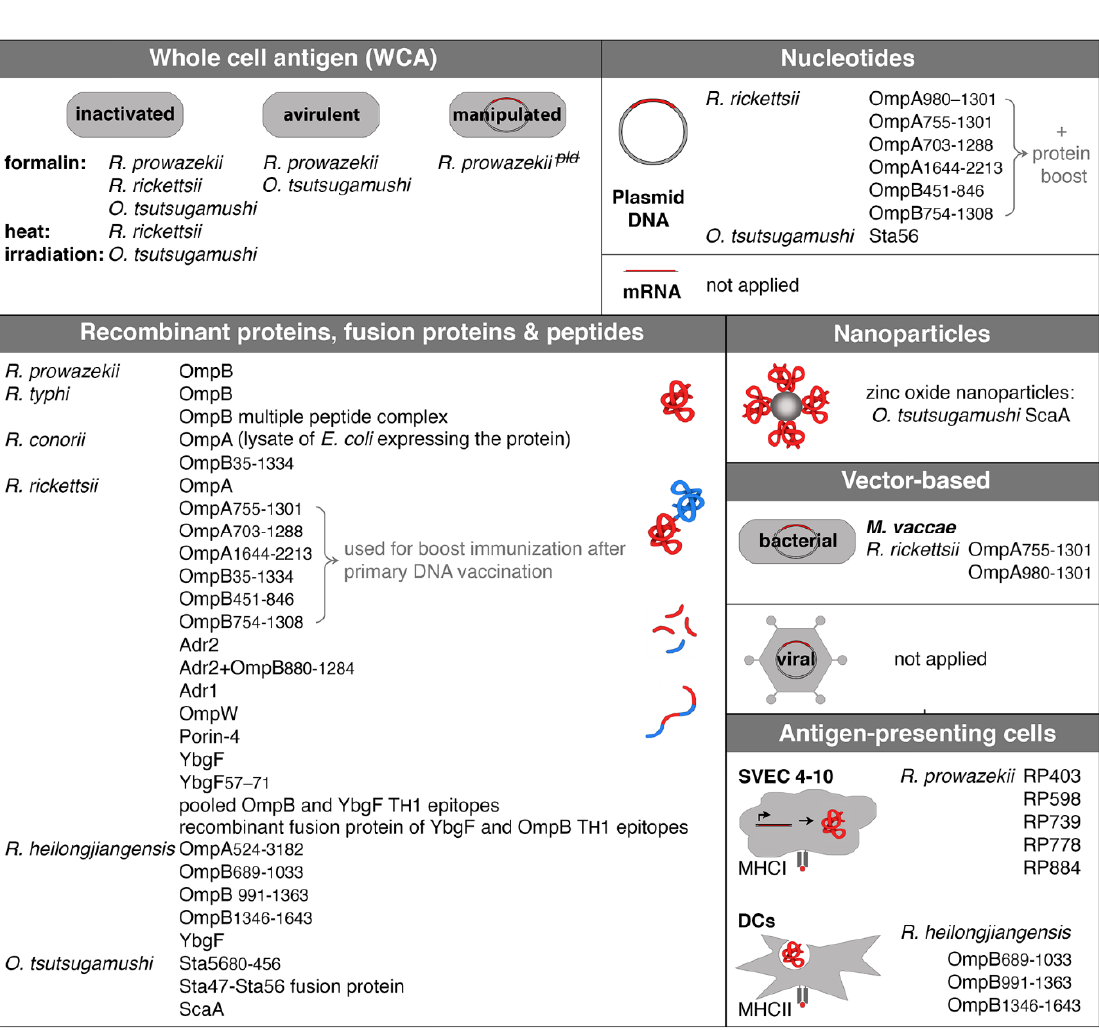
Figure 1. Experimental approaches of vaccination against rickettsiae. The figure shows all so far described approaches of vaccination against rickettsiae and names strains and antigens. WCA immunization was performed with either inactivated bacteria or avirulent strains. In addition, an attenuated knockout strain of R. prowazekii that lacks phospholipase D was generated and used for immunization in experimental infection of mice. The vast majority of vaccinations were performed with recombinant proteins, fusion proteins, or peptides. Other methods include recombinant protein coupled to nanoparticles, bacteria ( M. vaccae ), or transfected cells that express rickettsial antigens and DCs that were pulsed with recombinant protein. mRNA vaccination and vaccination with adenoviral vectors as they are used now for the immunization against SARS-Cov2 with great success have not been applied yet, but represent great new tools that should be taken under consideration.